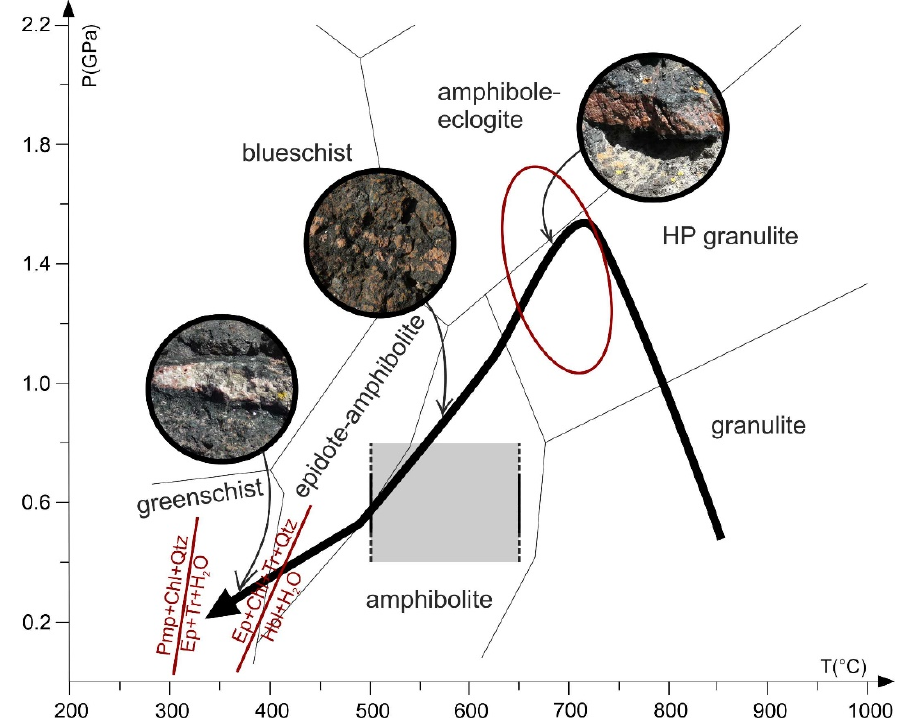
Figure 9. P–T path of the ultrabasic amphibolite documented by [35] (black arrow) compared with the P–T conditions for the Grt1 veins (red ellipse) and the subsequent amphibole (grey area) and epidote (reaction curves from [56]) occurrences in the vein system. Photographs in circles graphically describe the textural evolution of the garnet veins.